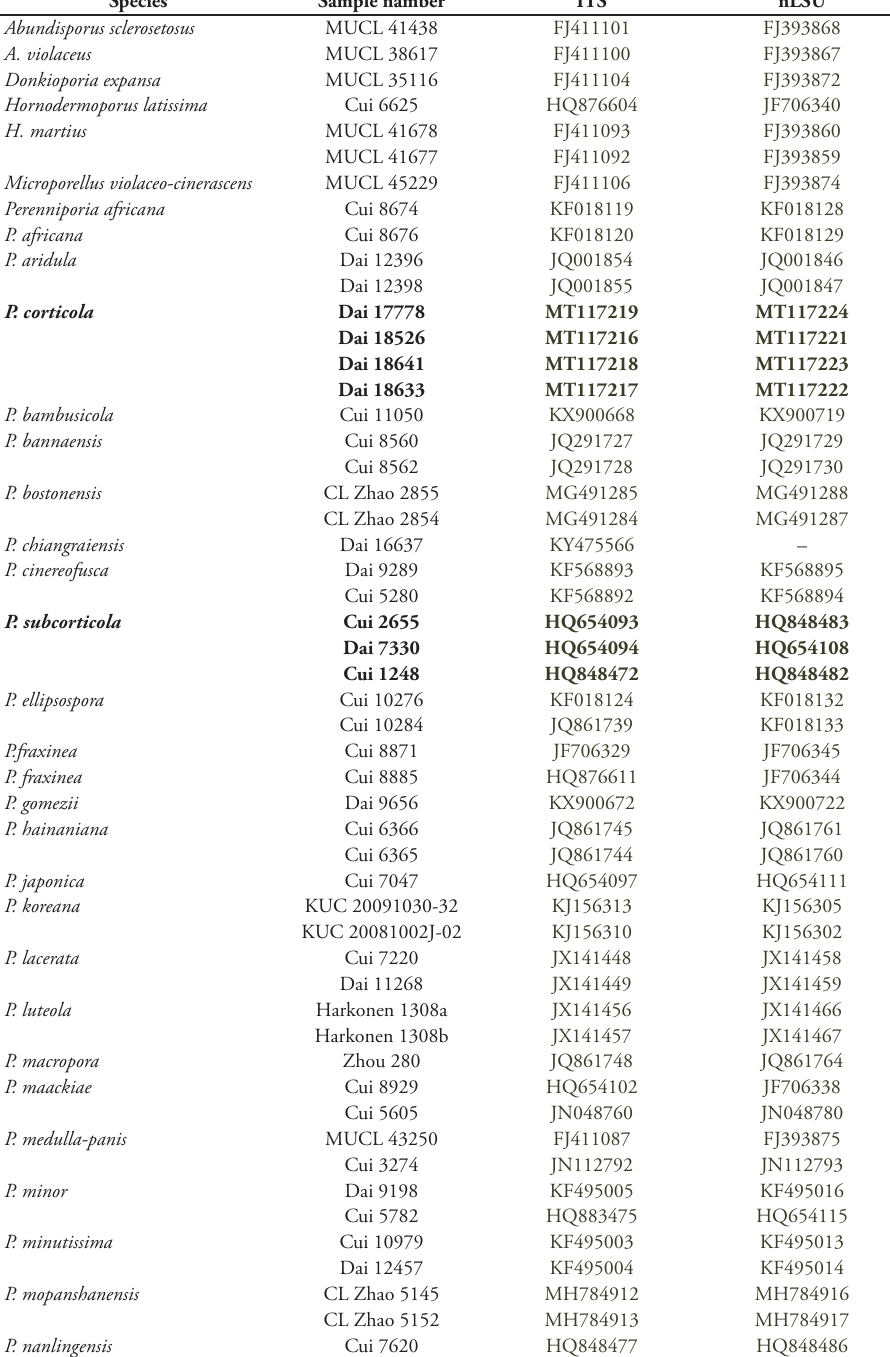
Table 1. Information for the sequences used in this